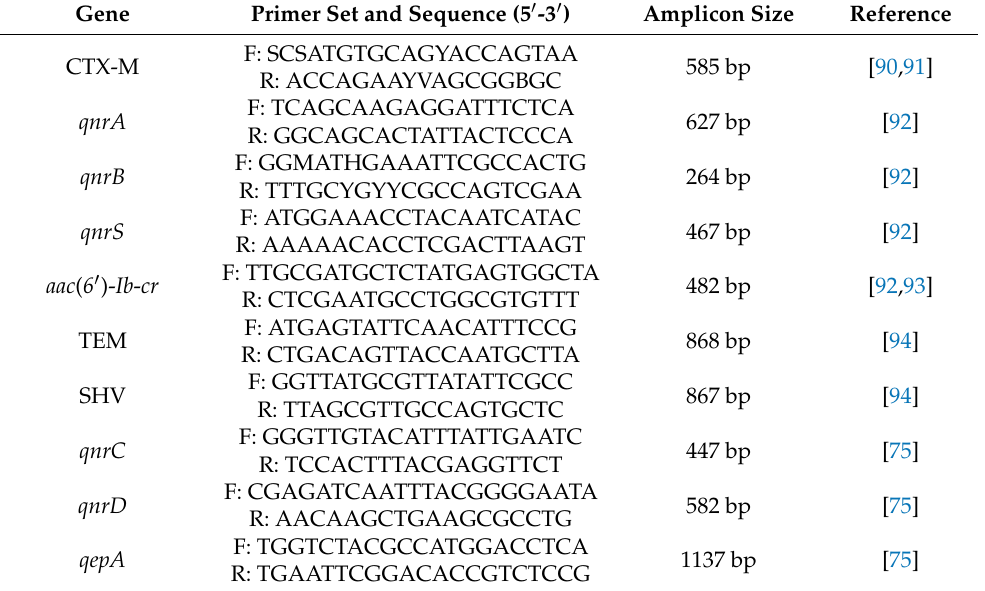
Table 10. PCR primers, sequences, and protocols used.